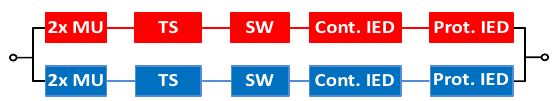
Fig. 2 Reliability Block Diagram of ‘one-out-of-two’ scheme [36]